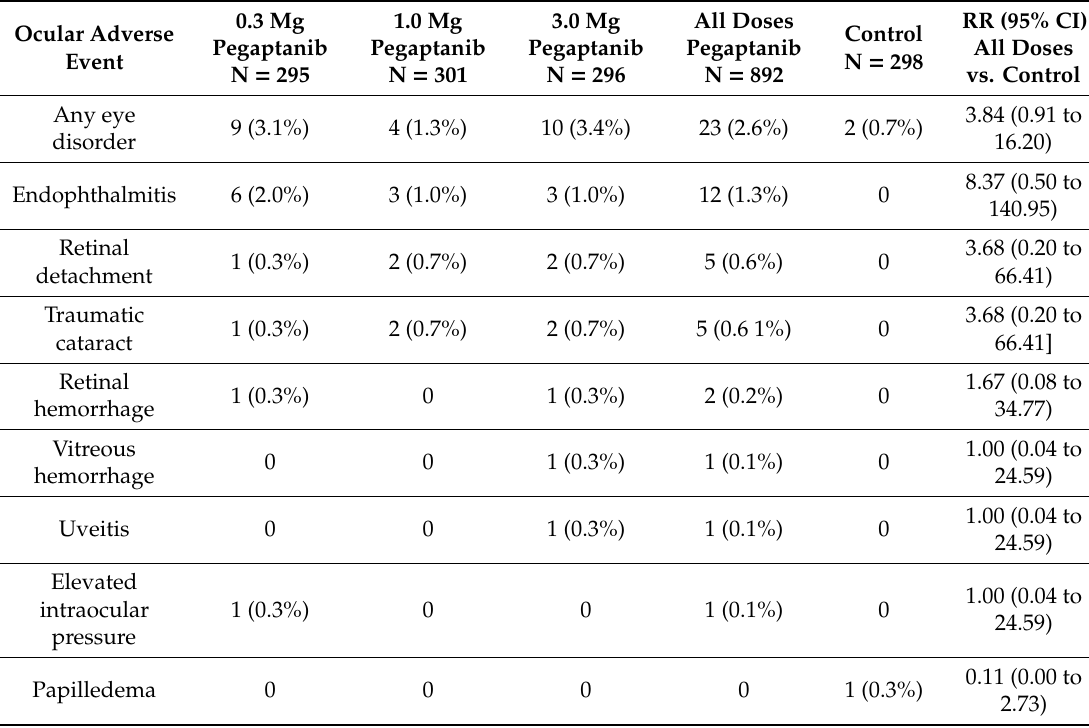
Table 3. An overview of the ocular adverse events reported by age-related macular degeneration patients treated with pegaptanib. Adapted from Solomon et al.